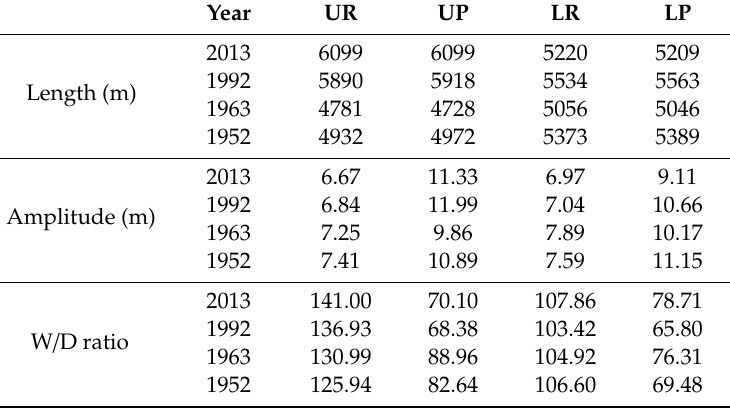
Figure 9. Frequency of pool–pool length (in orange) and riffle–riffle length (in blue) by channel widths (W/D ratio) at different times: 1952 ( A ), 1963 ( B ), 1992 ( C ), 2013 ( D ). Averaged W/D ratios of riffles or pools are also displayed in this figure. Table 4. The average values of the length (i.e., the length between two consecutive pools or riffles), amplitude (i.e., riffle height, pool depth), and W/D ratio (width-to-depth ratio) for riffles and pools in different survey years. These average values are displayed by riffles in the upper reach (UR) and lower reach (LR), as well as pools in the upper reach (UP) and lower reach (LP). The values in both length and amplitude represent distances in meters.